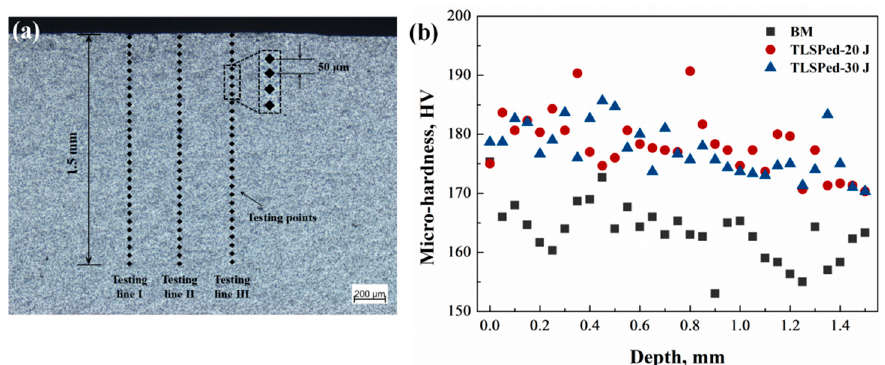
Figure 7. ( a ) The demonstration of microhardness measurement in the BM and LSPed specimens. ( b ) Microhardness distributions in the depth direction measured on the cross-section of BM, TLSPed-20 J and TLSPed-30 J specimens.